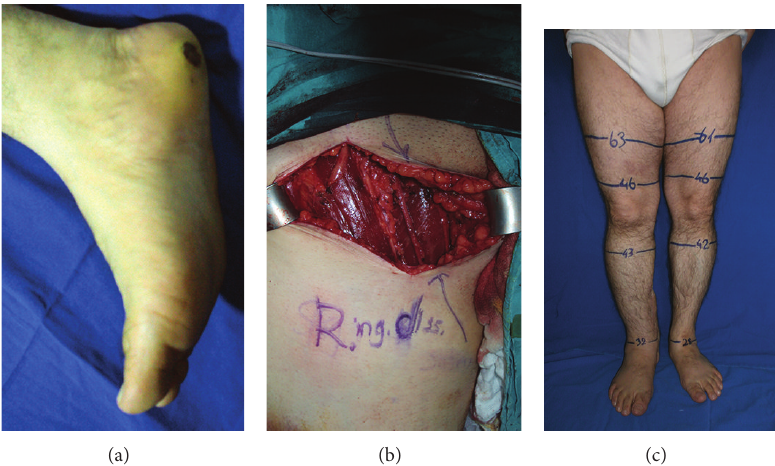
Figure 2: (a) Preoperative view of the 43-year-old male patient having T4 (4,8 mm) melanoma located to the right heel. (b) Right-sided saphenous vein superficial inguinal dissection, intraoperative view. (c) Postoperative 16th month picture, showing no sign of lymphedema (note that the right ankle is thick because of the use of posterior tibial artery perforator flap in the right heel